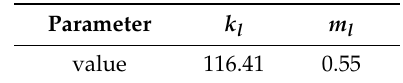
Table 3. Calibration results of Equation (6).